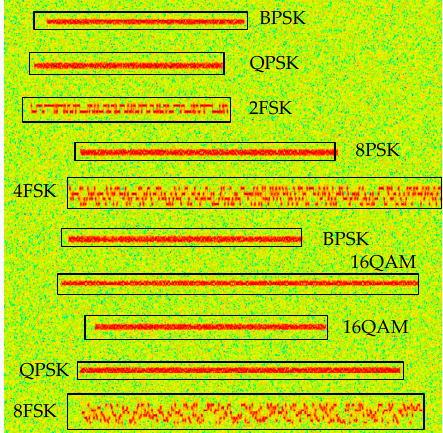
Figure 1. Di ff erent modulation signals in the Figure 1. Different modulation signals in the wideband.